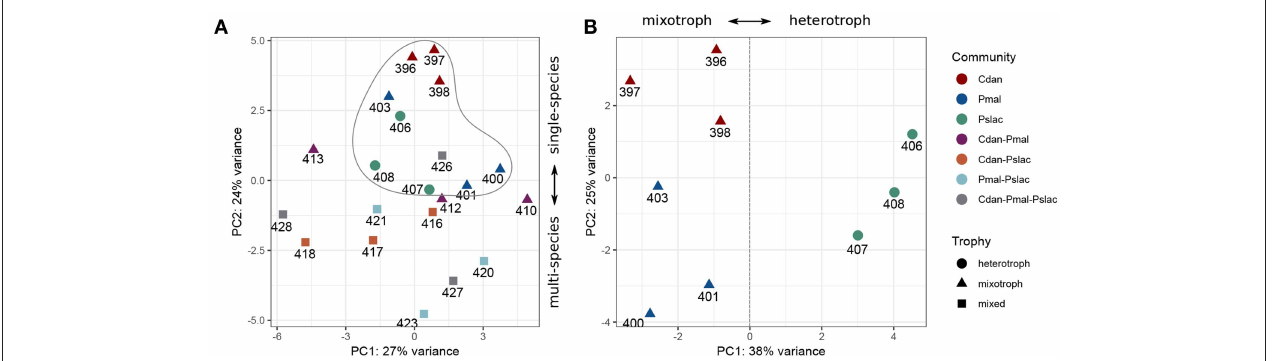
FIGURE 2 | Principal component analysis based on normalized gene-wise read counts for Pn. asymbioticus . (A) For all samples, (B) for single community samples. Samples are colored according to the protistan community and the shape depicts the trophic mode of the community. The sample community clearly influences the gene expression of Polynucleobacter , which can be seen in a separation between single- and multi-species samples (A) as well as a separation according to trophy (B)